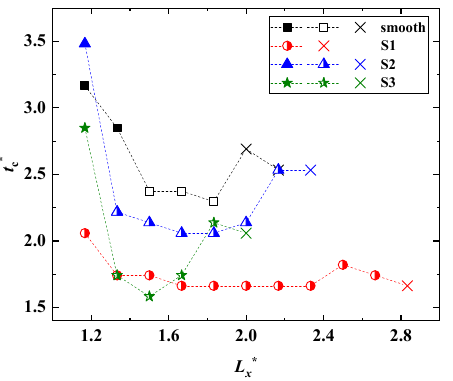
Figure 17. Comparison of contact times on the S1, S2, and S3 surfaces. Here, L y * = 0.67 on the S1 surface, and L y * = 0.58 on the S2 surface.